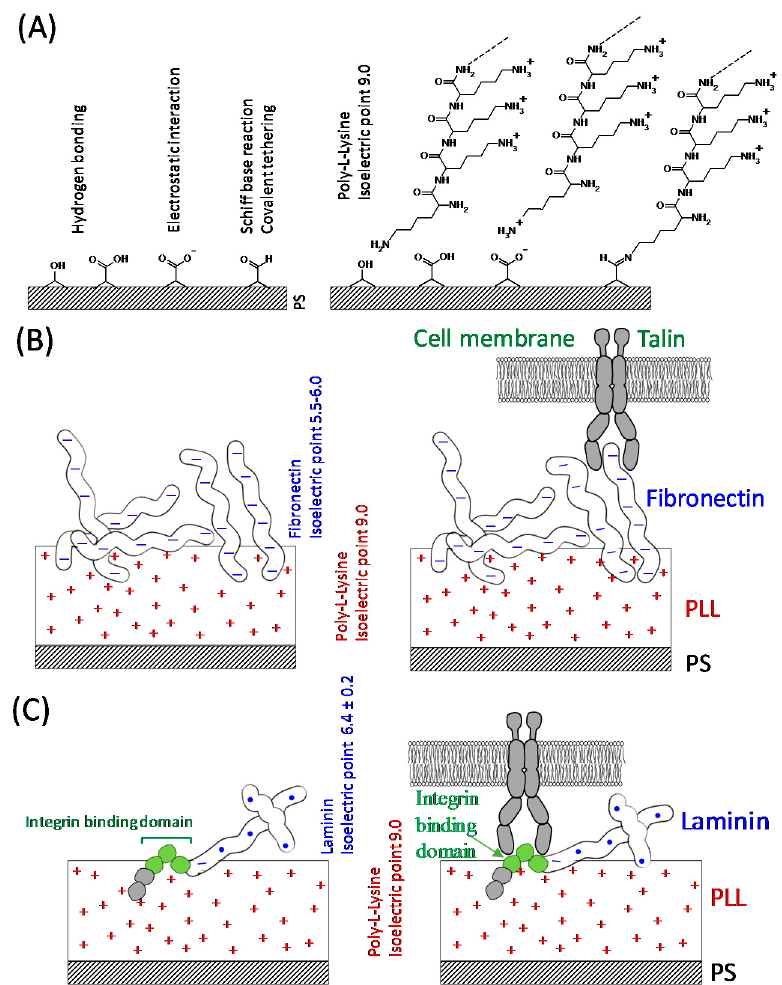
Figure 5. Schematic interpretation of the bio-interfaces of the PC12 cells undergoing attachment onto the substratum samples. ( A ) Possible chemical interactions between the polystyrene substratum and